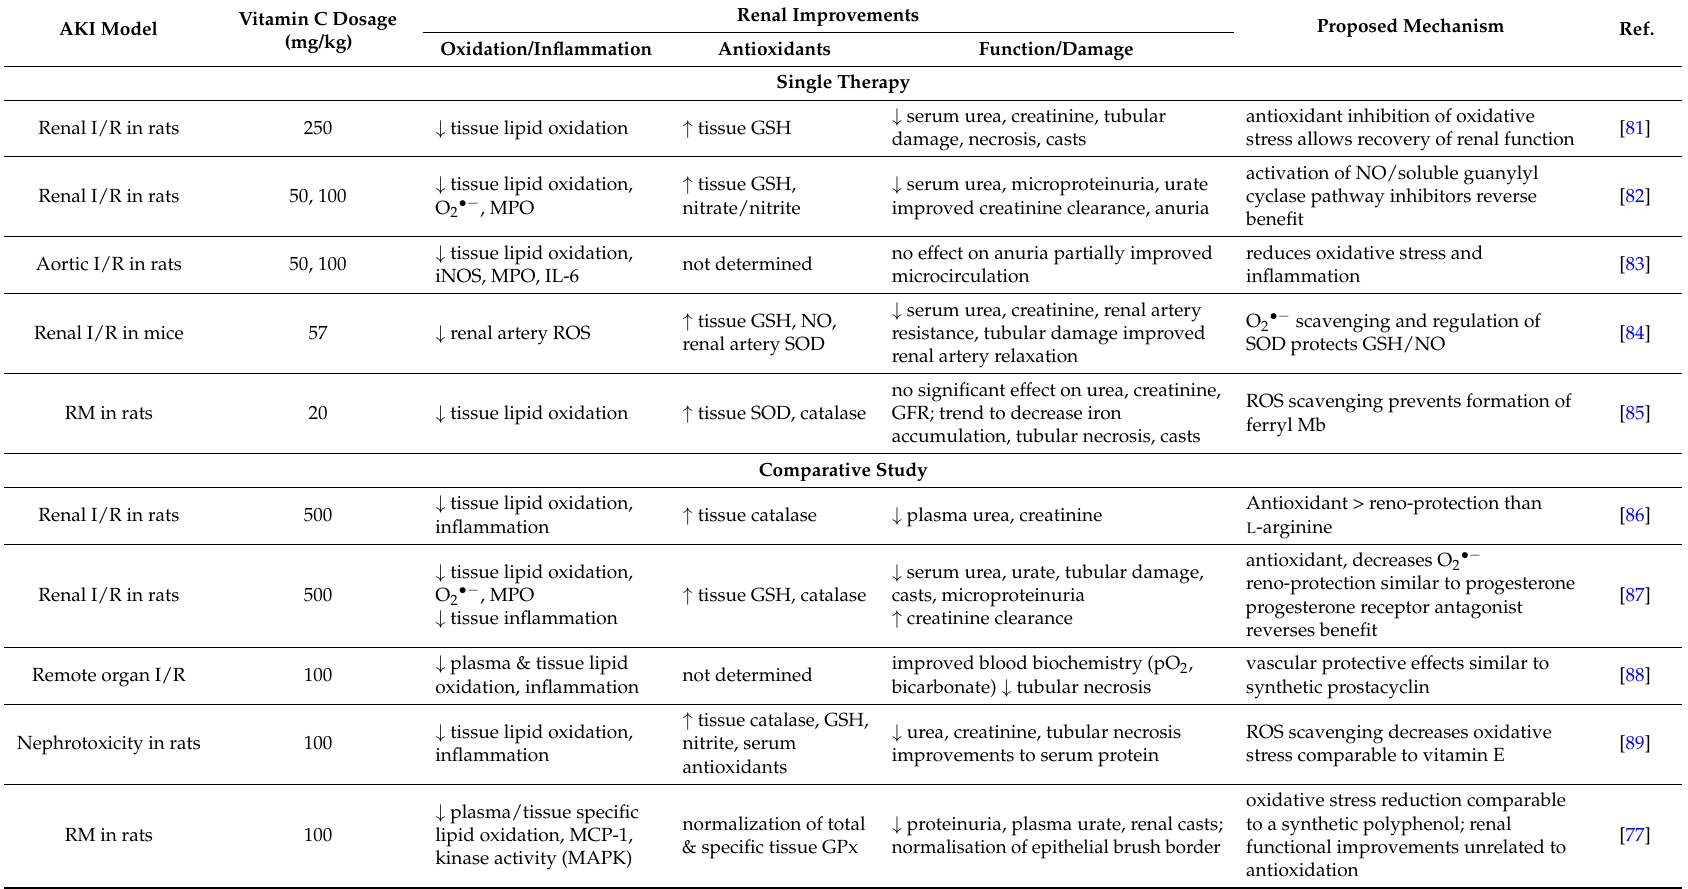
Table 1. Recent vitamin C intervention studies in animal models of ischemic, nephrotoxic and injurious